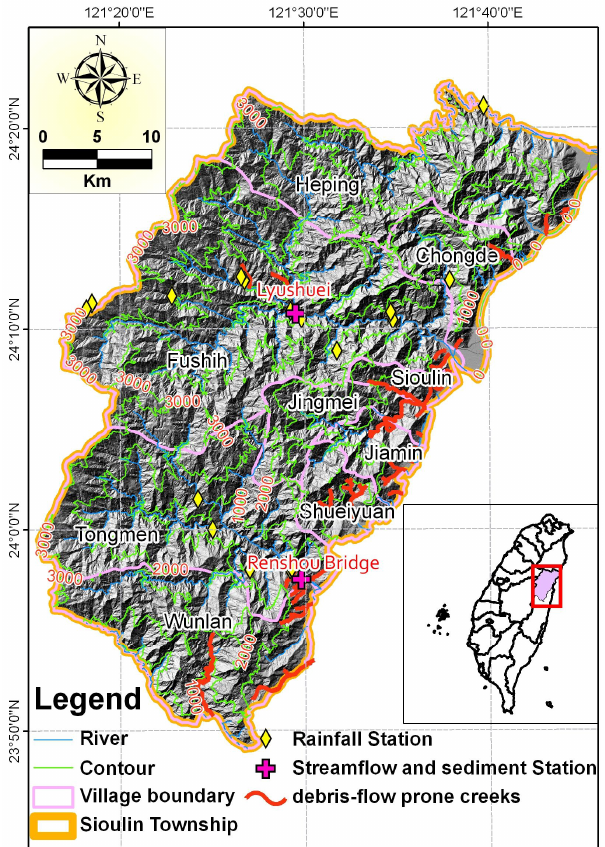
Fig. 1. Location of study area and distribution of debris-flow-prone Figure 1. Location of study area and distribution of debris-flow-prone creeks at Sioulin Town. 593 creeks at Sioulin 594